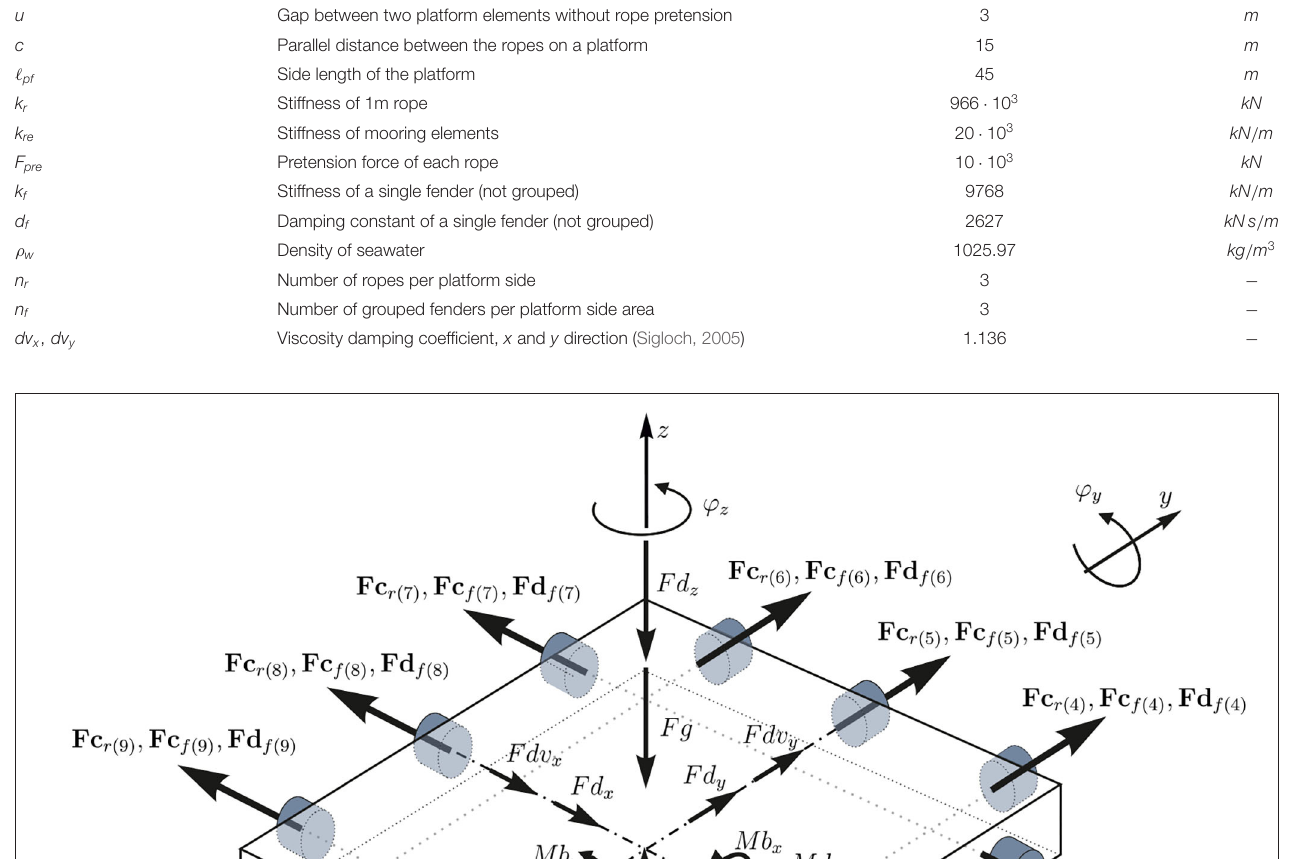
the Newton-Euler method, only a single free body diagram and one set of differential equations is necessary to calculate the mechanical behavior of the platform